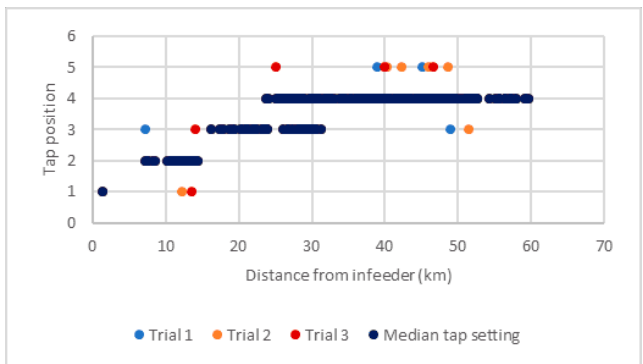
Figure 9. Metrics measured for Case 1.2. ( a ) Average error ∆ of the secondary voltages between the results of consecutive power flows. ( b ) Maximum absolute error ∆ max of the secondary voltages between the results of consecutive power flows.